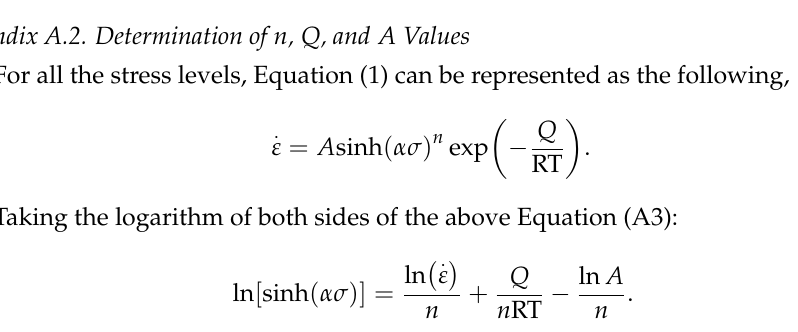
1 by plotting ln